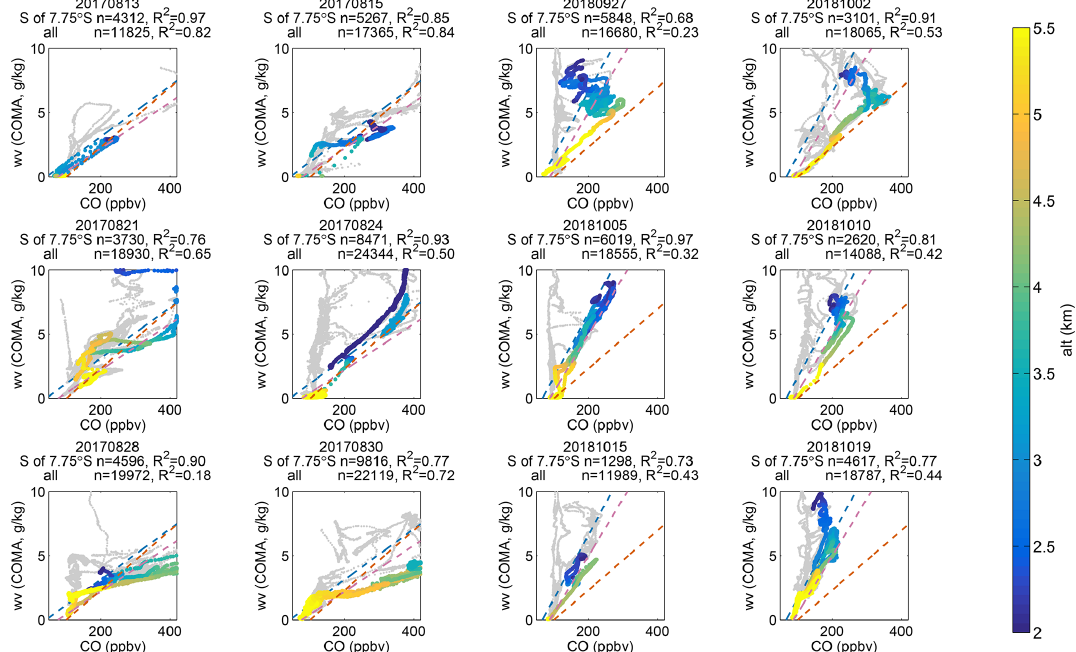
Figure 15. ORACLES-2017 (left) and ORACLES-2018 (right) water vapor vs. CO, for selected flights, for the subset of latitudes overlapping with the 2016 sampling region (south of 7.5 ◦ S; colored) and for the remainder of data at all latitudes above 2km (grey). The thick blue lines show the fits through all 2017 (2018) flights, and the purple lines indicate the fits through the portions of the 2017 (2018) flights which are south of 7.5 ◦ S and east of 0 ◦ E. The thick dashed red lines show the fits through all 2016 flights as in Fig. 3. The variation in this relationship from year to year is